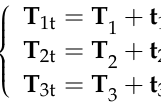
Figure 2. Diagram of the facet parameters and measurements of the parabolic mirror